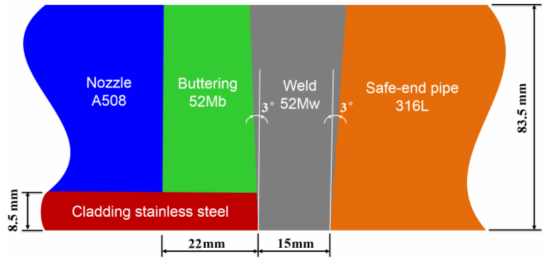
Figure 1. A dissimilar metal welded joint in a nuclear power plant.